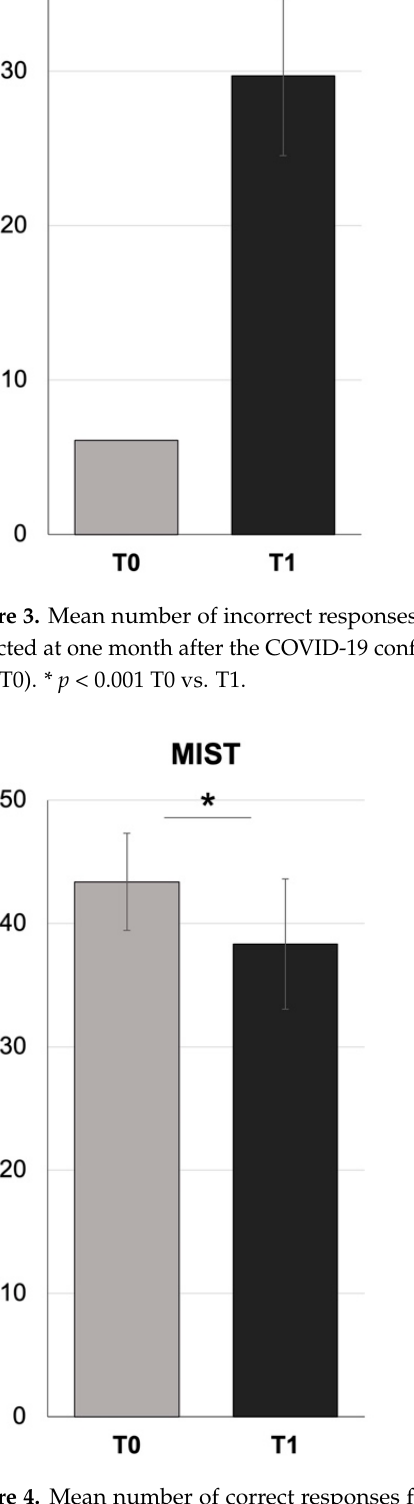
Figure 4. Mean number of correct responses for the prospective memory test (MIST). The results collected at one month after the COVID-19 confinement (T1) compared to the normative data for the test (T0). * p < 0.001 T0 vs. T1.